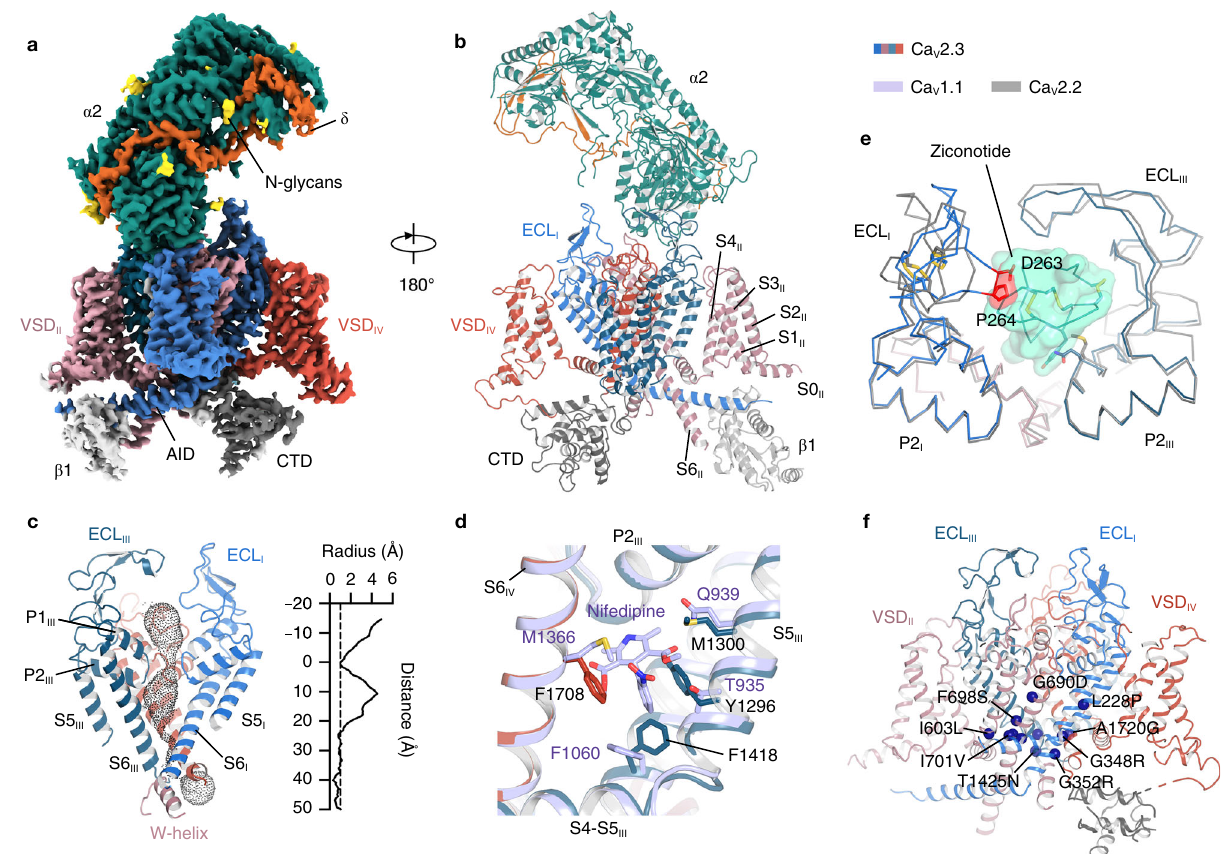
Fig. 1 | Architecture of the Ca V 2.3- α 2 δ 1 − β 1 complex. a , b Cryo-EM map ( a ) and model ( b ) of the Ca V 2.3- α 2 δ 1 − β 1 complex. The Ca V 2.3 α 1E pore-forming sub- unit are colored pink, red, blue, and deep cyan. The C-terminal domain (CTD) of Ca V 2.3 are colored gray. The auxiliary subunits α 2, δ , ανδ β 1 are colored green, orange, and white, respectively. c The ion-conducting pathway and pore pro fi ling of the Ca V 2.3. The ion-conducting pathway is viewed in parallel to the membrane and shown in black dots. The radius of the pore is calculated using the HOLE program. The vertical dashed line marks the 1.0-Å pore radius, which represents the ionic radius of calcium. d Superimposition of the DIII-IV fenestration between Ca V 2.3 and Ca V 1.1 complex. The nifedipine molecule